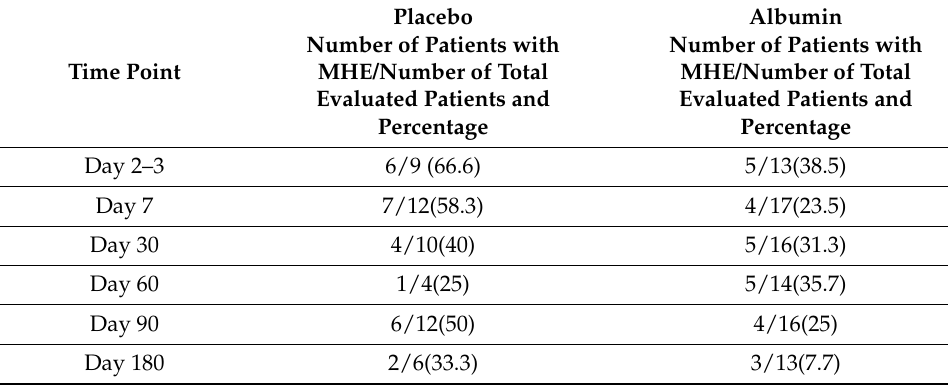
Table 2. Baseline characteristics of the BETA trial by treatment